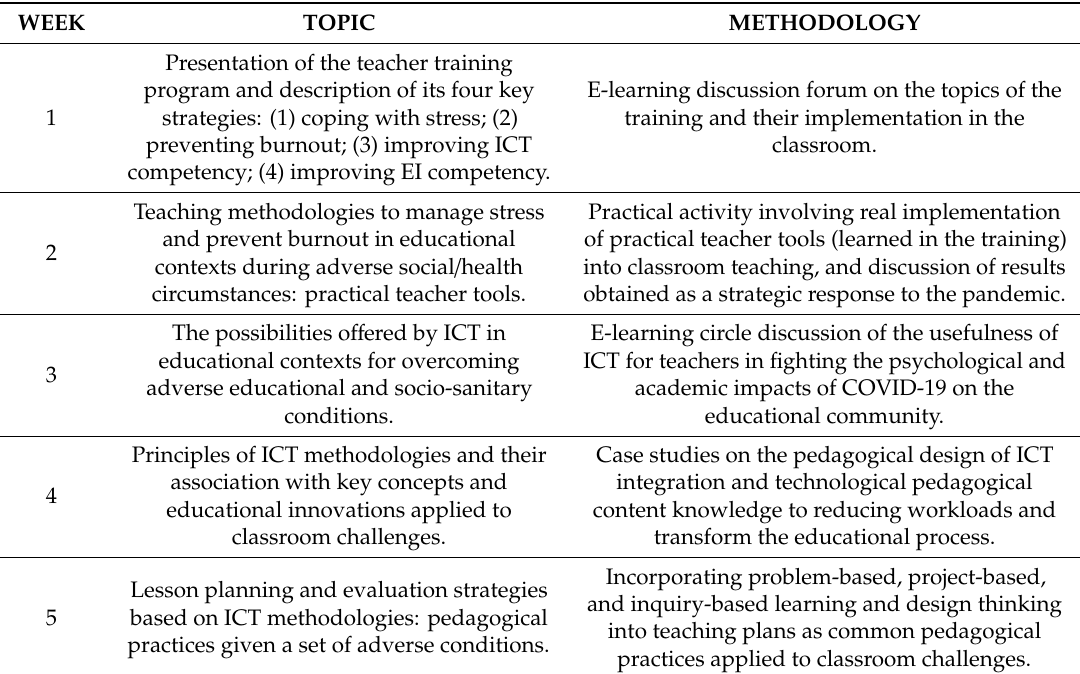
Table 1. Teacher Training